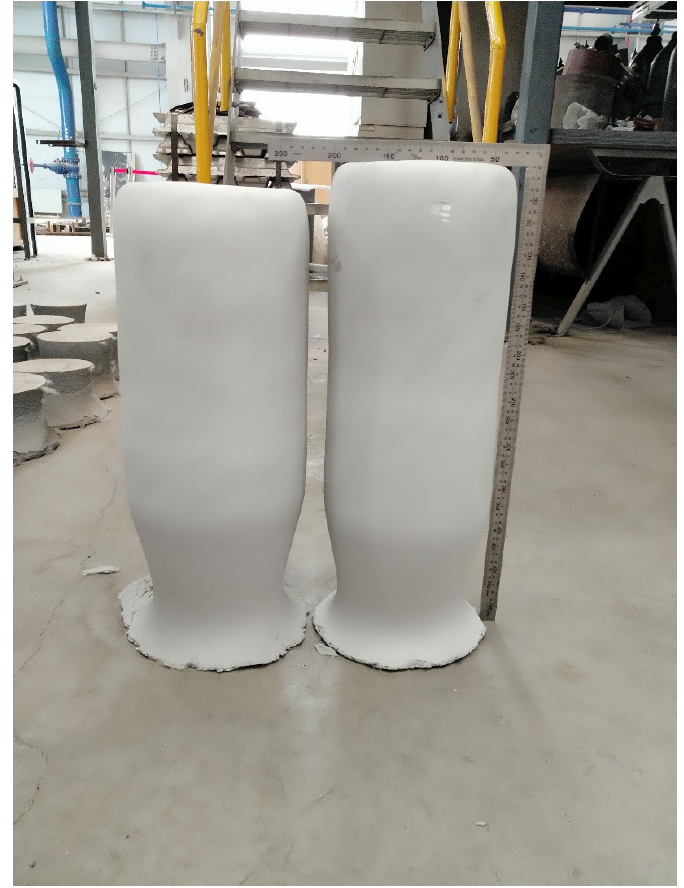
Figure 12. Photo of spray-formed alloy ingot.